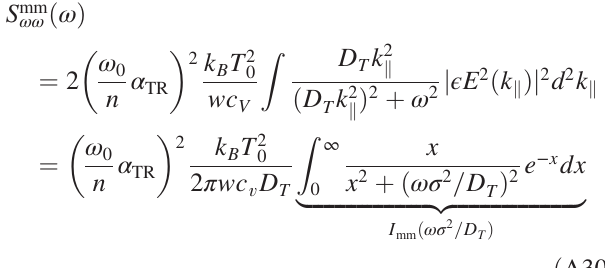
FIG. 7. Normalized noise spectra of finite